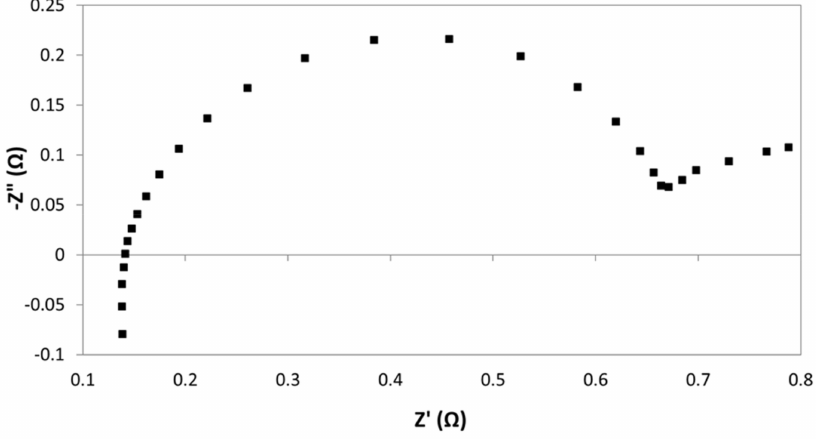
Figure 11. Example of the results from EIS measurements of diaphragm